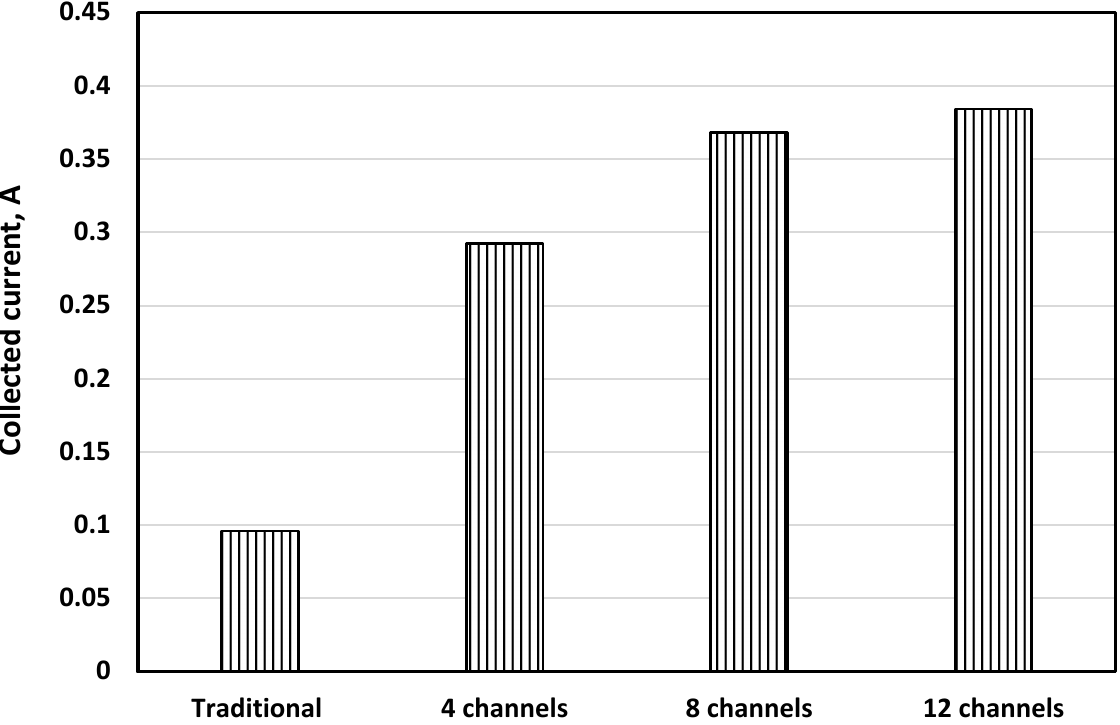
Figure 7. Collected current from different fuel cell designs.